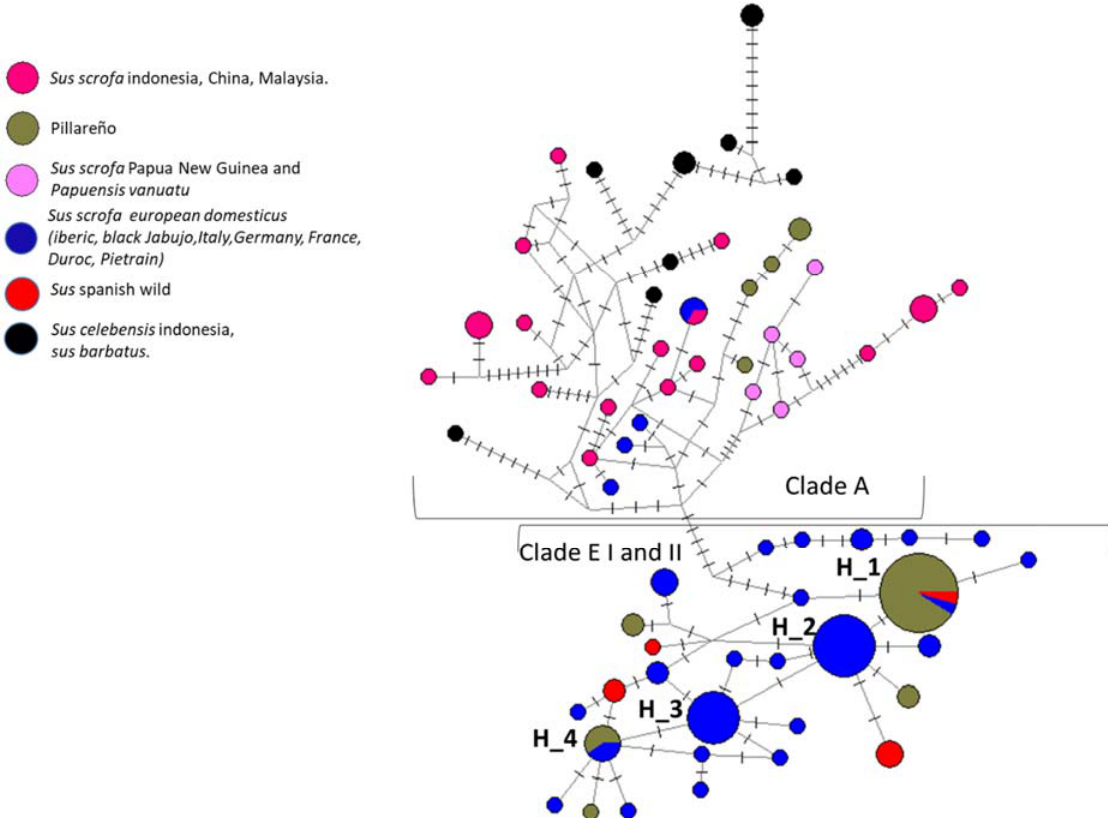
Figure 2. Median-joining haplotype network. Circles represent haplotypes identified in different clades; areas of the circles are proportional to frequency, and colors represent the populations, including Asia, Pillareño, European, and wild